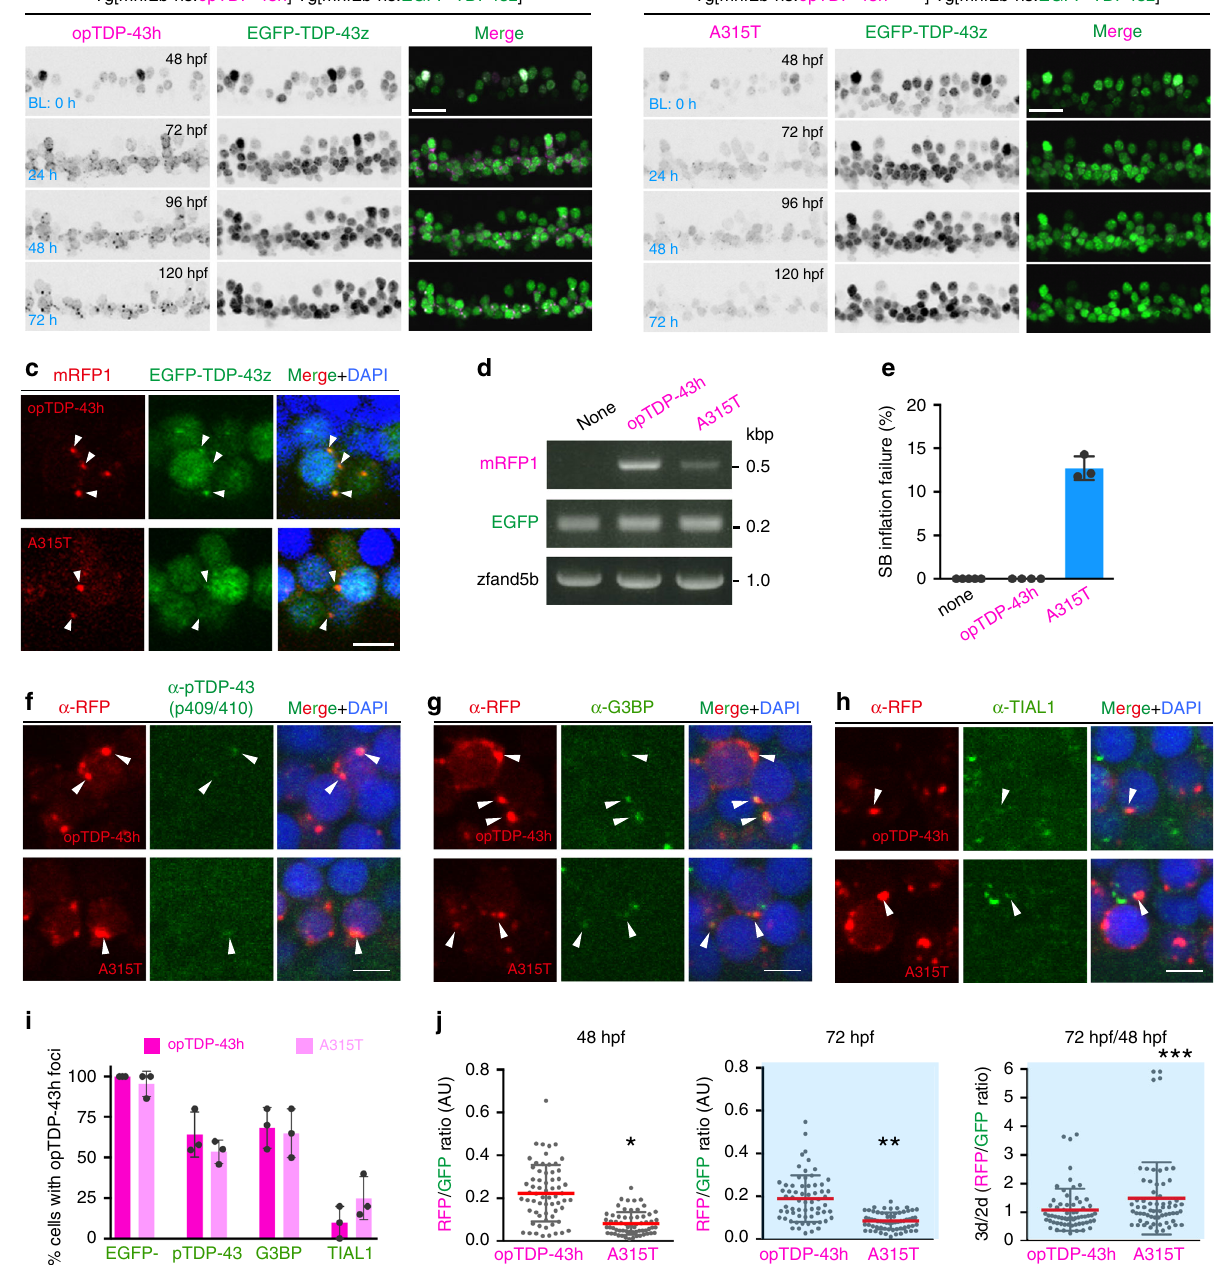
Fig. 7 The IDR mutation A315T enhances protein stability and oligomerization-dependent toxicity. a , b Live imaging of the spinal motor column from 48 to 120 hpf. c Chronically light-stimulated opTDP-43h (top) and opTDP-43h A315T (bottom) aggregate in the cytoplasm and seed EGFP-TDP-43z aggregation. Arrowheads indicate opTDP-43 and opTDP-43h A315T aggregates that contain EGFP-TDP-43z. d RT-PCR analysis for opTDP-43h and opTDP- 43h A315T transcripts at 72 hpf. e Failure rate of swimming bladder (SB) in fl ation of Tg[mnr2b-hs:EGFP-TDP43z] (none), Tg[mnr2b-hs:EGFP-TDP43z] Tg [mnr2b-hs:opTDP-43h], and Tg[mnr2b-hs:EGFP-TDP43z] Tg[mnr2b-hs:opTDP-43h A315T ] (A315T) larvae at 120 – 144 hpf. The average failure rates were de fi ned from at least three independent assays where six or more fi sh were illuminated (Source data are provided as a Source Data fi le). SB in fl ation failure was not observed when fi sh were raised under normal dark light cycles ( N > 100 for each). f – i Immuno fl uorescence analyses of phospo-TDP-43 ( f ), G3BP ( g ), TIAL1 ( h ) against cytoplasmic opTDP-43h and opTDP-43h A315T aggregates at 120 hpf. At least, twenty cells with distinct opTDP-43h or opTDP- 43h A315T aggregates were examined for each of three independent fi sh. j Stability of opTDP-43h or opTDP-43h A315T . Fluorescence intensities of opTDP- 43h or opTDP-43h A315T (RFP) relative to EGFP-TDP-43z (GFP) were examined at 48 hpf and 72 hpf, in the same set of 64 cells from three independent animals. * p < 0.0001, ** p < 0.0001, *** p = 0.03 (unpaired t -test, two-tailed). The bars indicate 20 µ m ( a , b ) and 5 µ m ( c , f – h ). Error bars show